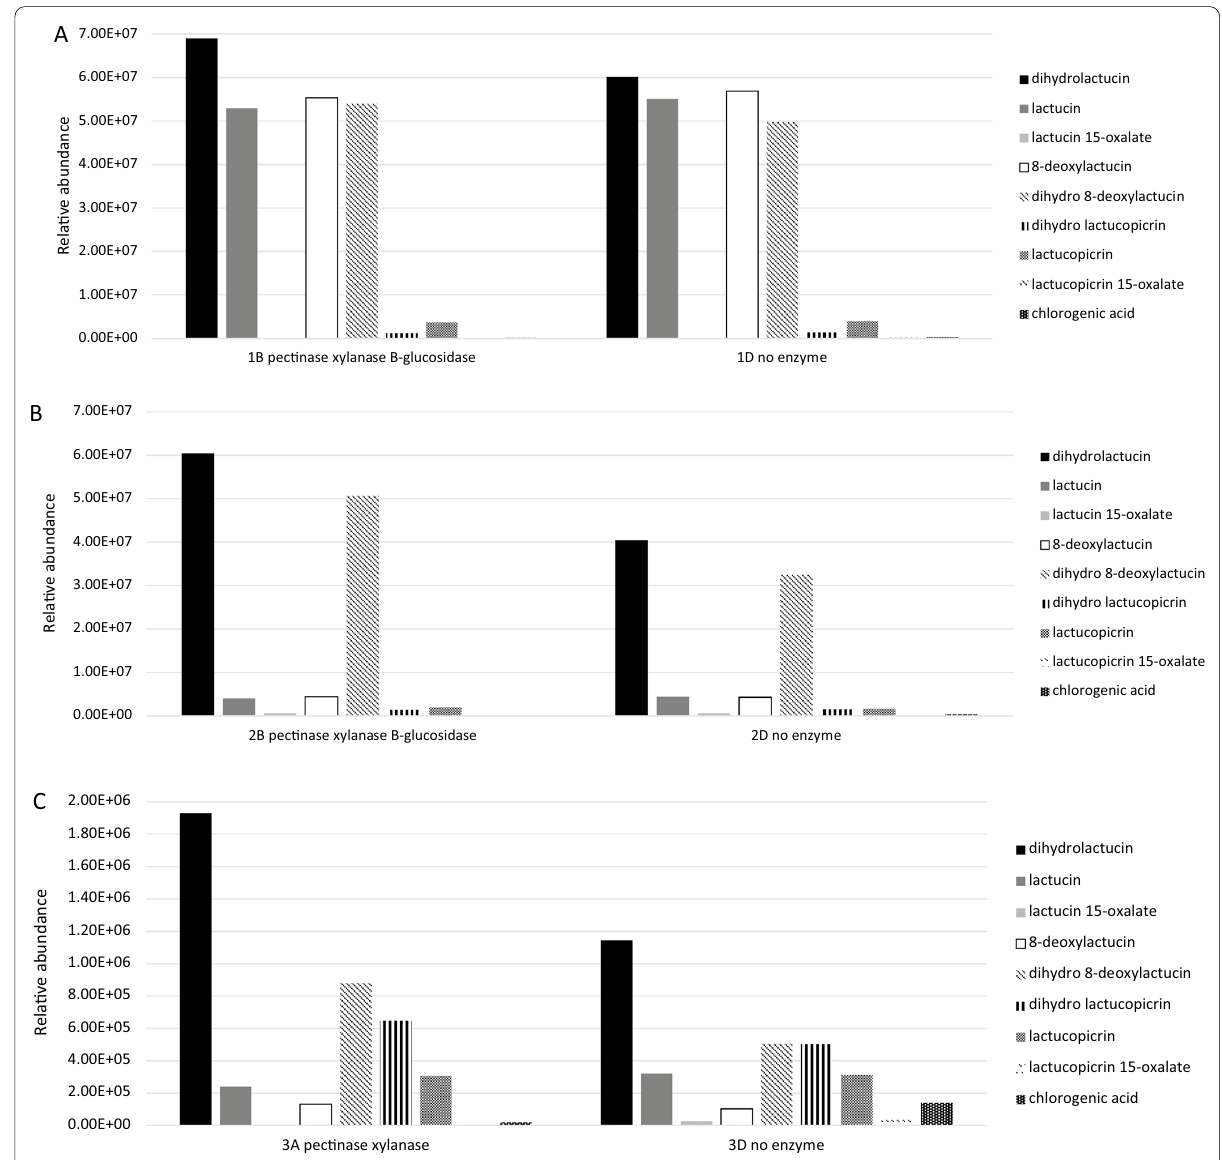
Fig. 2 LC‑Orbitrap‑FTMS analysis of chicory extracts before and after the most effective enzymatic treatments. A Sample #1 (Belgian endive). B Sample #2 (industrial chicory roots, before inulin extraction). C Sample #3 (industrial chicory root biomass, after inulin